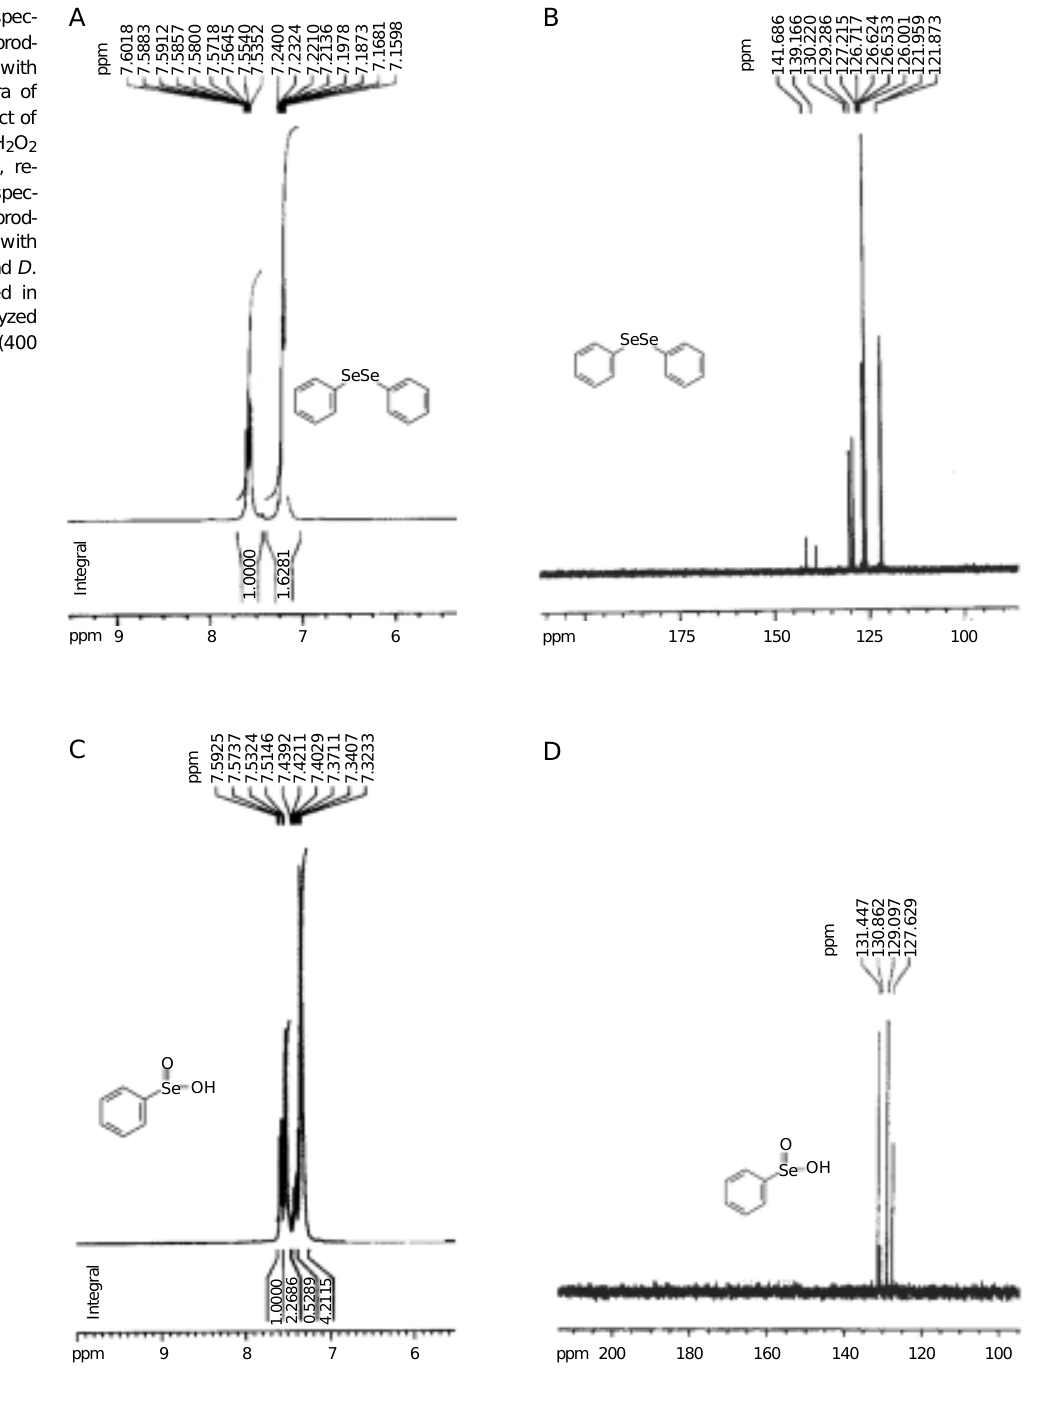
Figure 4. 1 H- and 13 C-NMR spec- tra of PhSeSePh and of the prod- uct of reaction of PhSeSePh with H 2 O 2 . The 1 H-NMR spectra of PhSeSePh and of the product of reaction of PhSeSePh with H 2 O 2 are presented in A and C , re- spectively. The 13 C-NMR spec- tra of PhSeSePh and of the prod- uct of reaction of PhSeSePh with H 2 O 2 are presented in B and D . Compounds were dissolved in CDCl 3 /D 2 O and then analyzed with a Bruker DPX-400 (400 MHz)